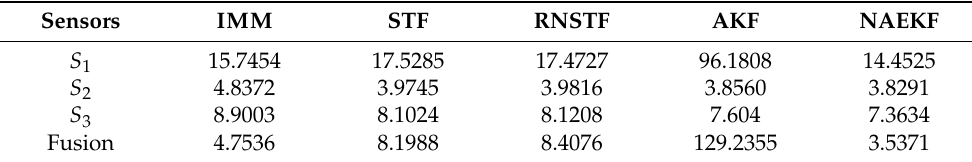
Figure 7. σ -Boundary of position estimation errors. ( a ) σ -Boundary of the range; ( b ) σ -Boundary of the azimuth angle; ( c ) σ -Boundary of the elevation angle. Table 5. Estimation errors of the range (m).